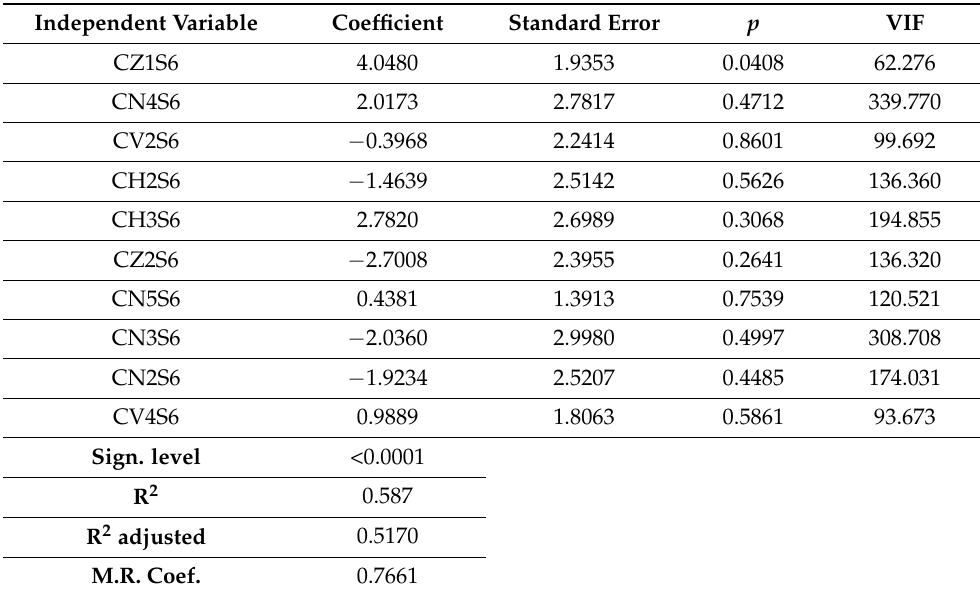
Table 4. Multivariate analysis of factors independently associated with the presence of metastatic lymph